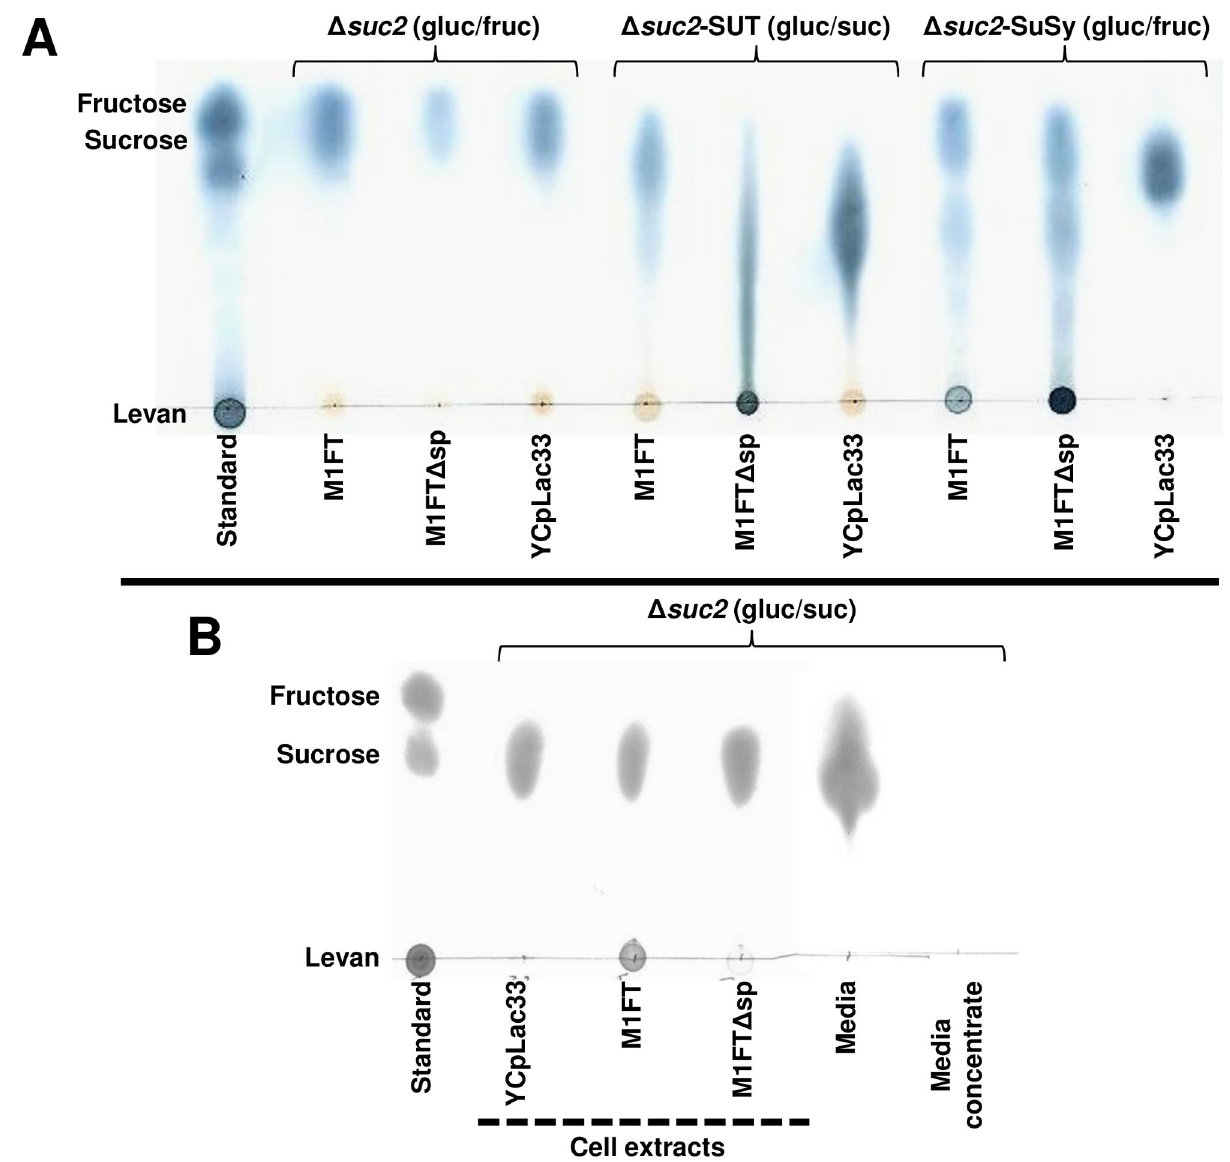
Figure 2. Thin-layer chromatographic analysis of levan production by M1FT. The presented TLC plates are representative of observations confirmed by at least three biological repeats. Fructose containing molecules were visualized using a urea spray after separation on TLC plates. (A) Cell extracts of strains expressing either the full-length M1FT, M1FT without signal sequence (M1FTΔsp) or the vector (YCpLac33) as control in BY4742Δ suc2 (grown in glucose and fructose containing media) and the two sucrose accumulating strains BY4742Δ suc2 -SUT and BY4742Δ suc2 -SuSy (grown in glucose and sucrose; and glucose and fructose containing media respectively). (B) Levan production by M1FT in BY4742Δ suc2 grown in media containing glucose as carbon source, supplemented with 5% sucrose. Cell extracts are indicated with a dashed line. The growth medium was either spotted directly from the supernatant (Media) or as a 500X concentrate of the same supernatant after ethanol precipitation (Media concentrate); in both cases, no levan production could be